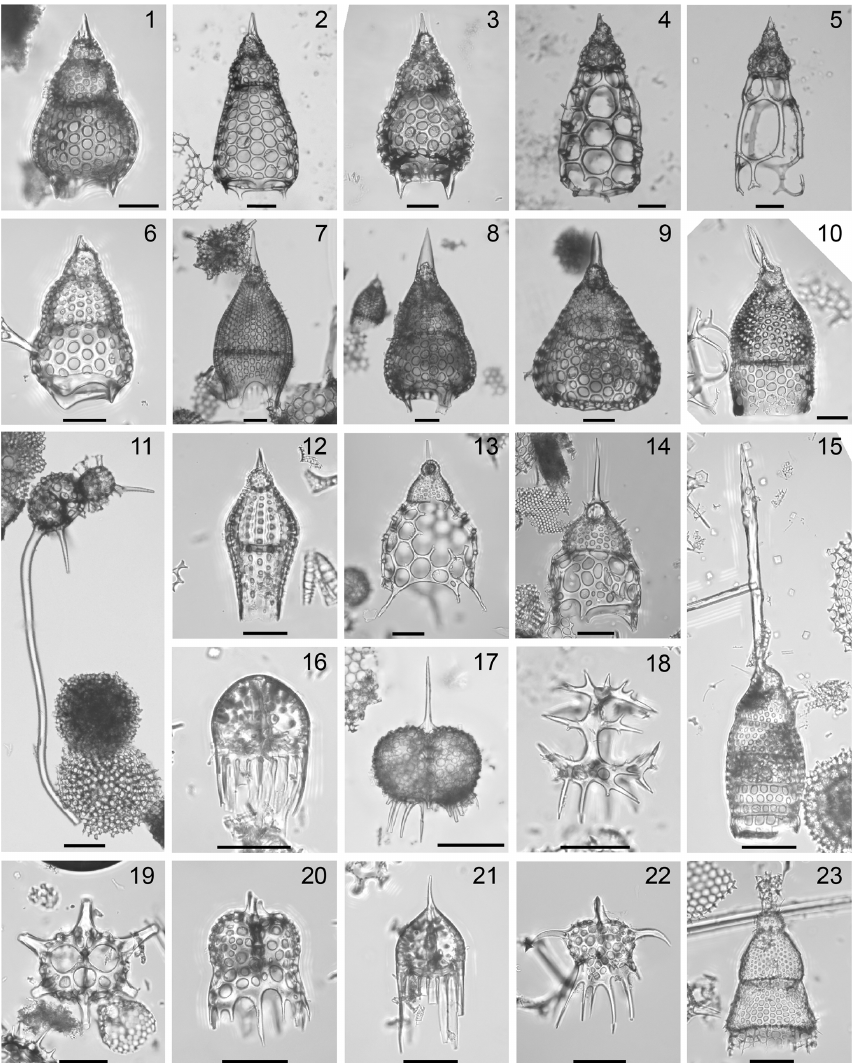
Plate 2. Composite light micrographs of selected radiolarians from ODP Site 1260. All scale bars equal 50µm. (1) Podocyrtis ( Lampterium